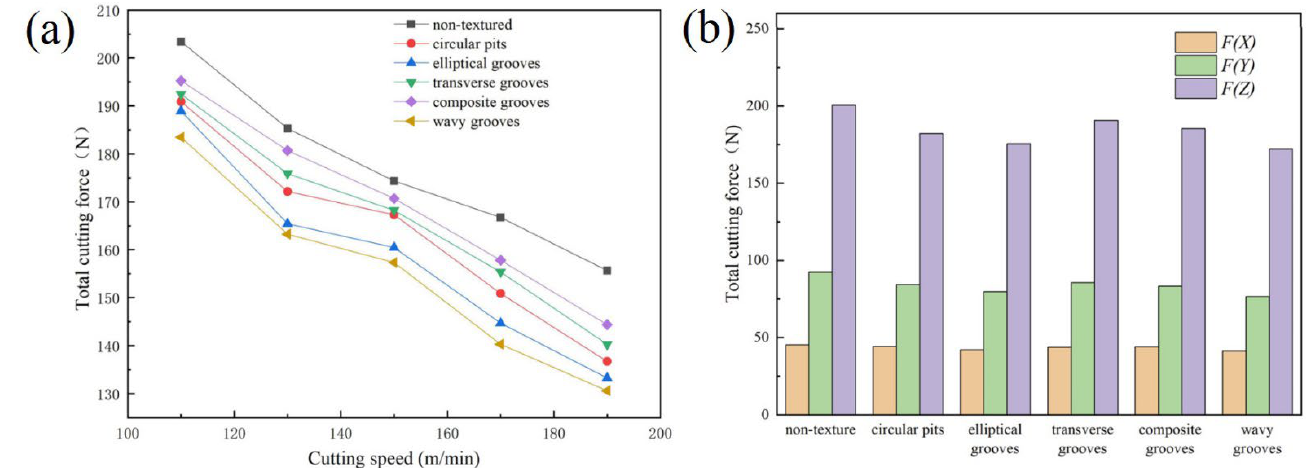
Figure 23. Total cutting force: ( a ) vs. cutting speed predicted by FEA; ( b ) results obtained by cutting experiments [82].